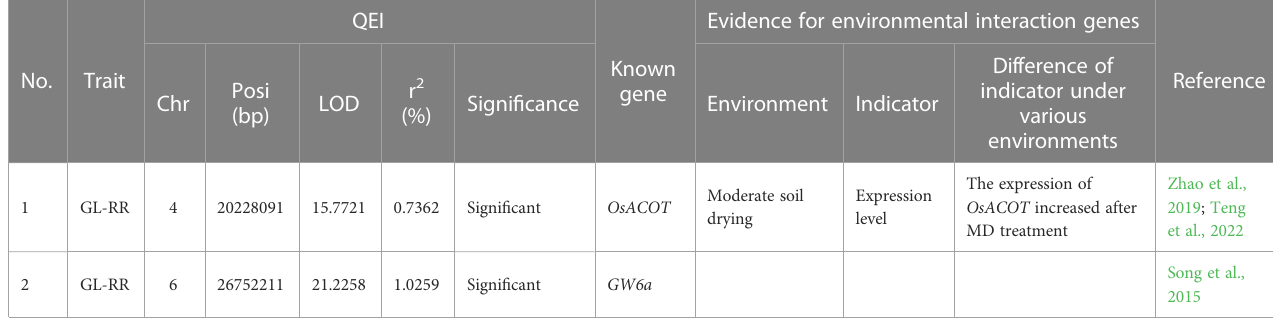
TABLE 2 Two known genes around QEIs for rice grain size traits in ratoon rice (RR) and the evidence of gene-by-environment interactions.